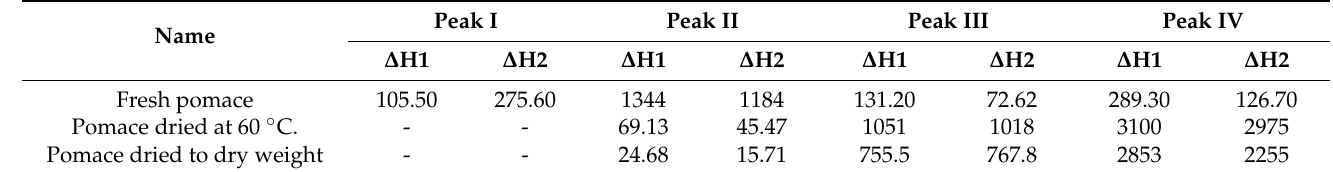
Table 7. Enthalpies of transformation (J/g) for apple-pomace samples based on the obtained DSC curves. Analysis in an oxygen atmosphere.